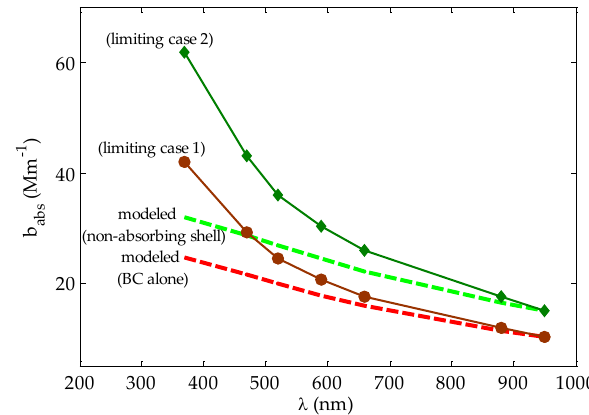
Fig. 1. The two limiting cases described in Sect. 2.2.3 to determine measurement-constrained absorption coefficients. Data (symbols) are from the fresh pocosin pine